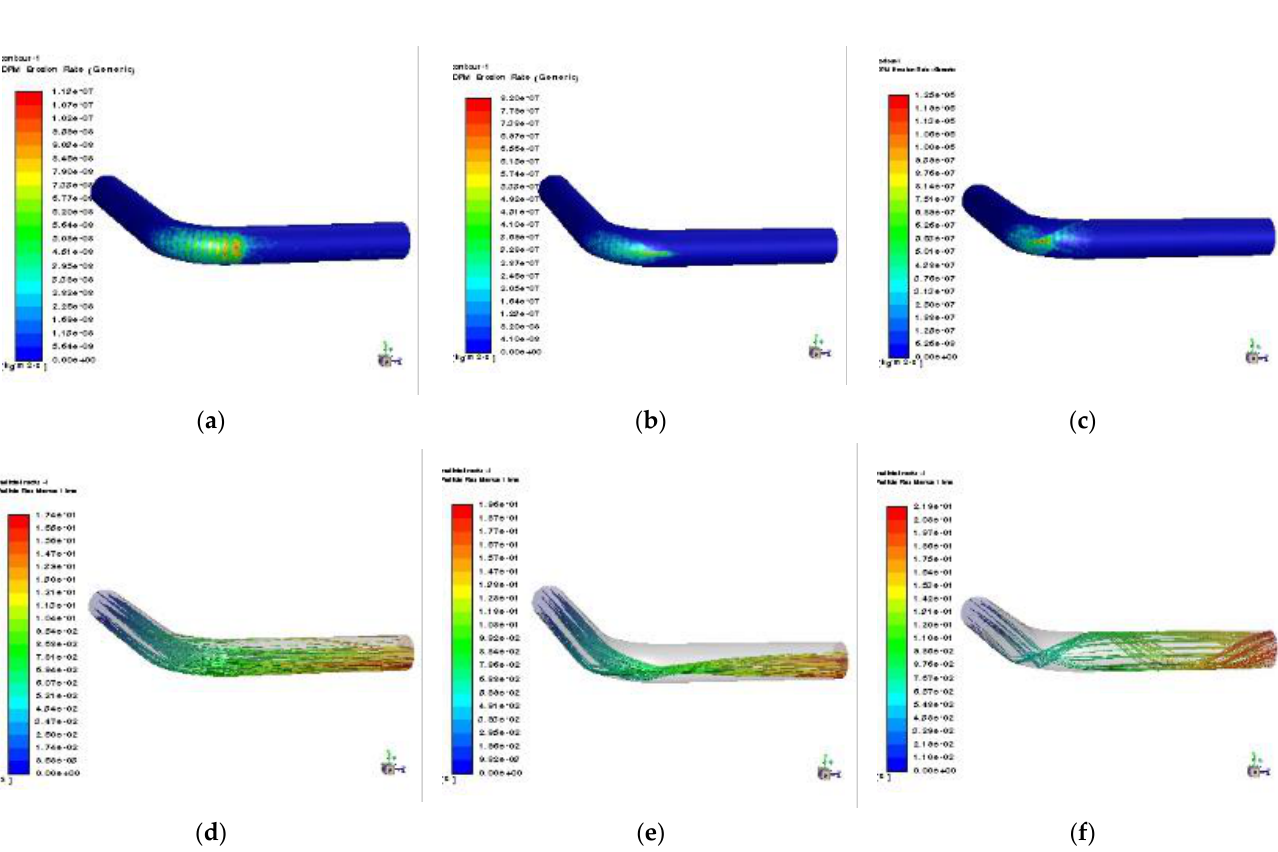
Figure 11. Erosion rate distribution and particle trajectories in the elbow with different particle diameter. ( a ) erosion rate distribution of 25 μm; ( b ) erosion rate distribution of 100 μm; ( c ) erosion rate distribution of 500 μm; ( d ) particle trajectories of 25 μm; ( e ) particle trajectories of 100 μm; and ( f ) particle trajectories of 25 μm.